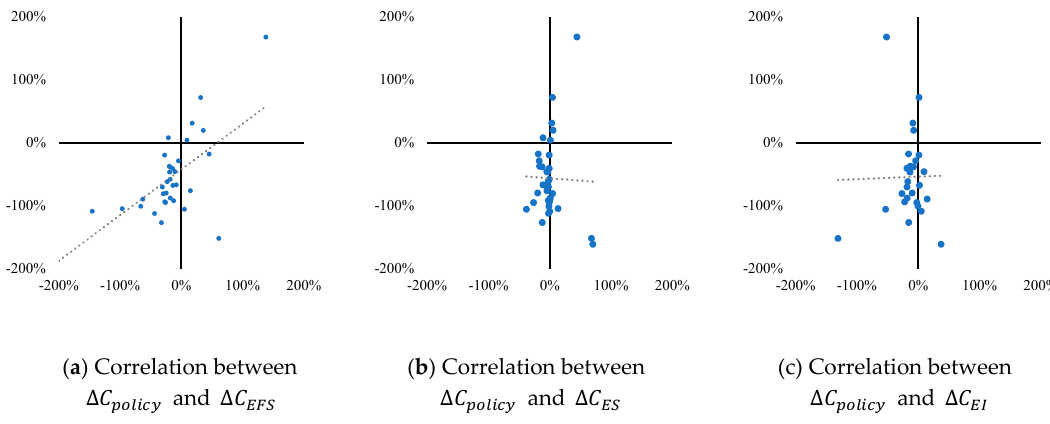
Figure 6. Correlation between total policy effect and supply-side policy factors driving CO 2 emission.